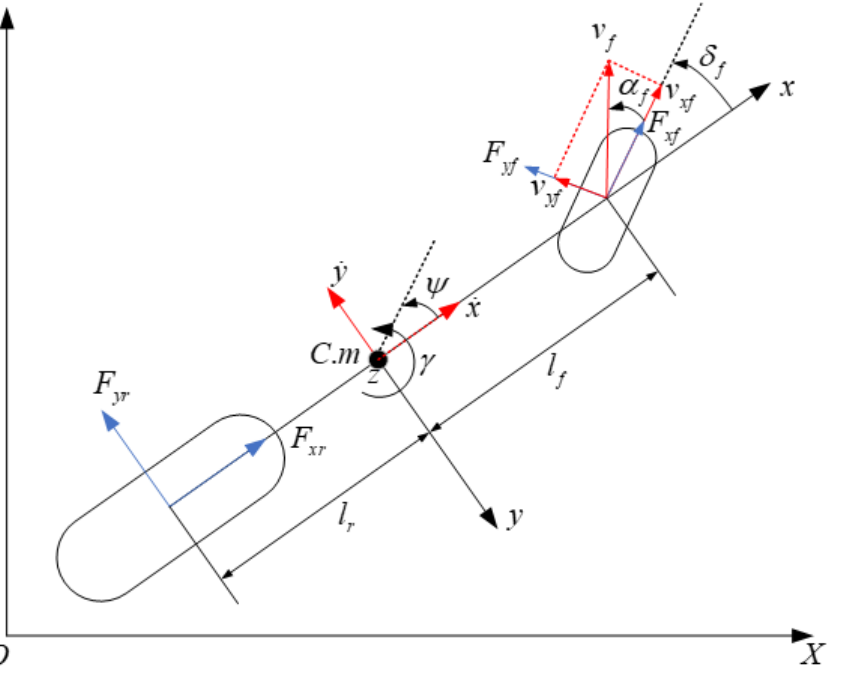
Figure 1. The 2-wheel tractor dynamic model. Table 1. Nomenclature of the 2-wheel tractor dynamic model.